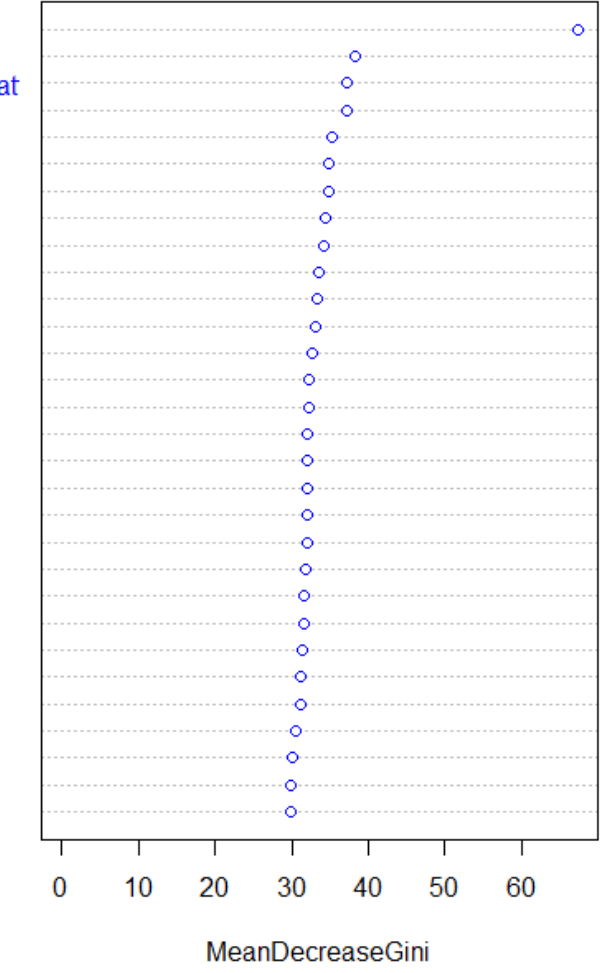
Figure 17. Variable importance from random forest model on risk